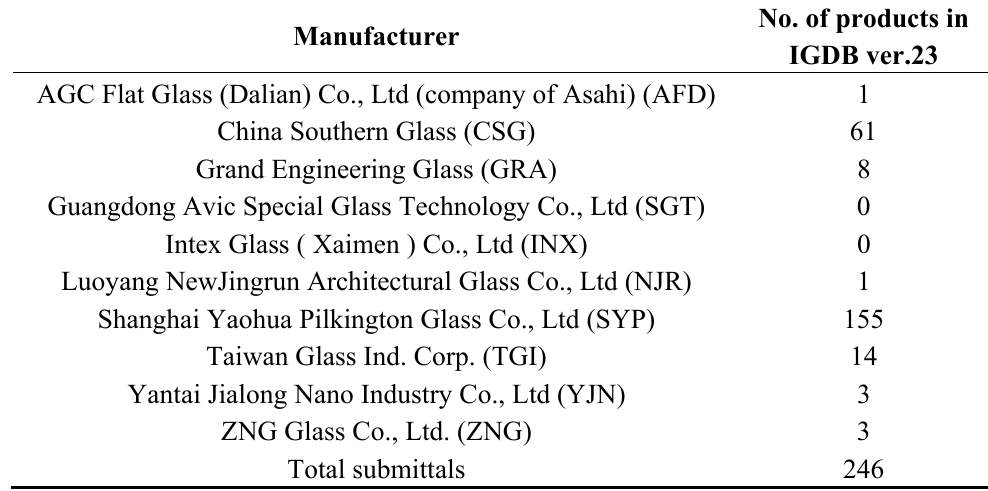
Table 3. Chinese glass manufacturers with submittals in the International Glazing Database